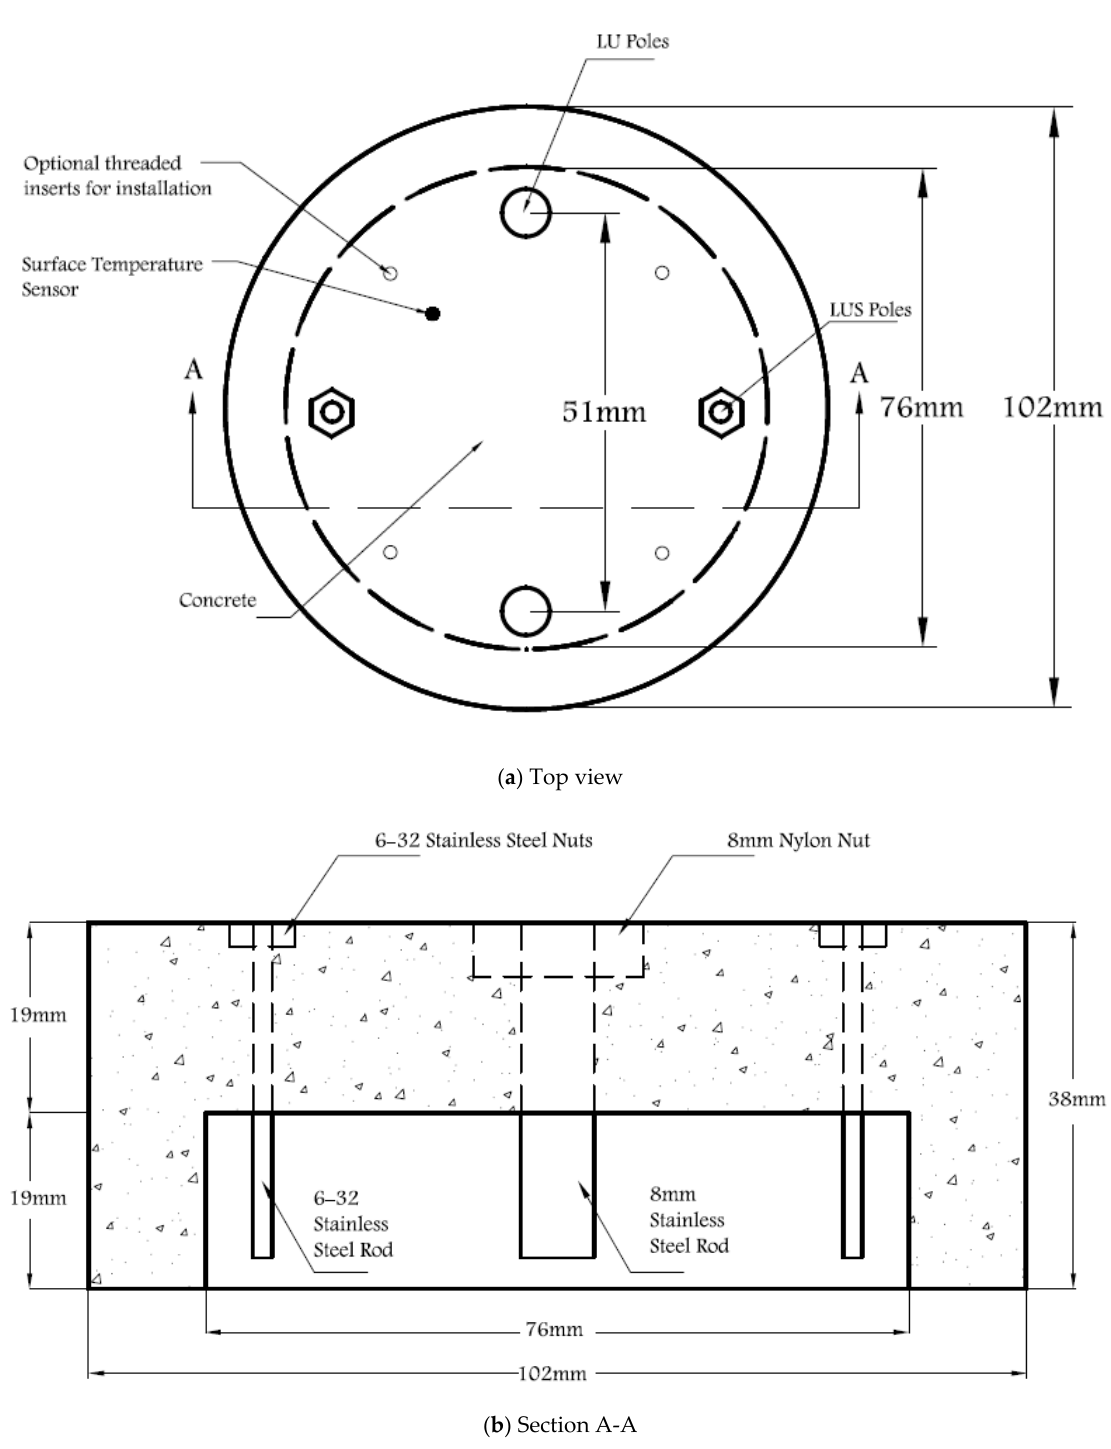
Figure 1. Dimensions of the proposed sensor: ( a ) Top view; ( b ) Section A-A.